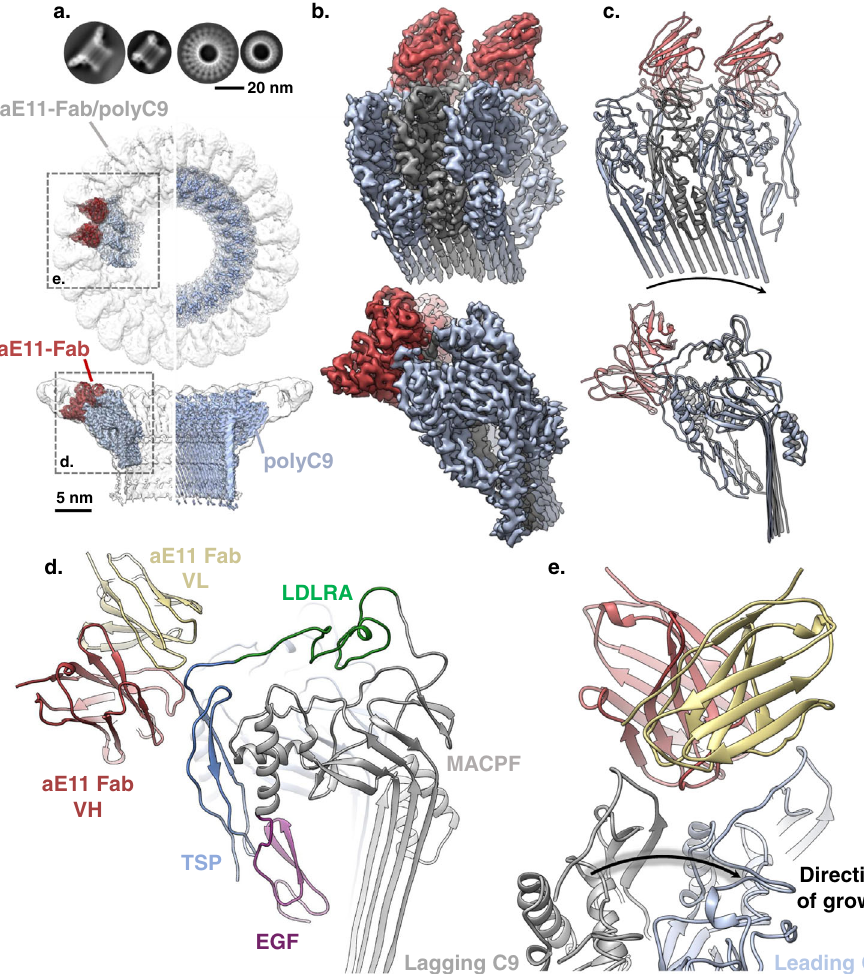
Fig. 1 Cryo-EM reconstruction of aE11-Fab/polyC9. a Above: comparisons of 2D class averages between polyC9 alone and aE11-Fab/polyC9. Below: 3D density map comparison between top-down and side orientations of the full cryo-EM maps of the aE11-Fab/polyC9 complex (transparent grey surface) and unbound polyC9 (blue). Left: focused re fi nement of C9 trimer (blue) with aE11-Fab (red) positioned in the global map of aE11-Fab/polyC9 (transparent grey). Right; unbound polyC9 alone (EMDB: 7773). b Focused view of the boxed region from (a; oblique and side views), three C9 subunits, and two aE11- Fabs are shown as isosurfaces. c Corresponding cartoon representation of the atomistic model derived from ( b ). The direction of MAC assembly is indicated by the arrow. d The positions of the heavy (H) and light (L) chains of aE11-Fab, in red and beige, respectively, and domains of the C9 subunit: MACPF (grey) and ancillary domains TSP (blue), LDLRA (green), and EGF (purple). e Top-down view of the aE11-Fab wedged between the two C9 protomers, de fi ned as leading (light blue) and lagging (grey) subunits. Black arrow shows direction of